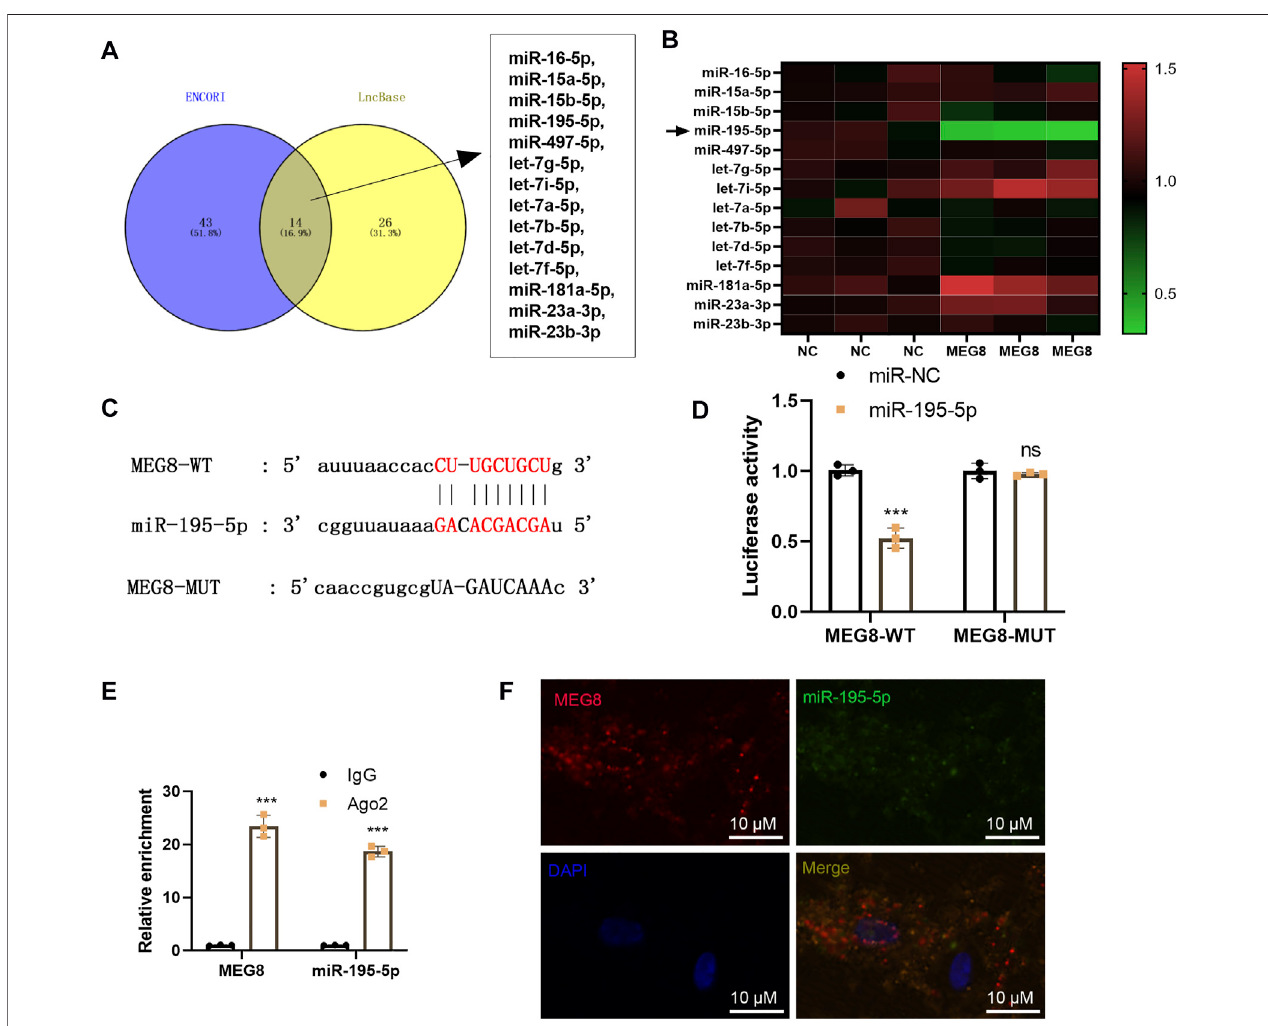
FIGURE4| MEG8targetedmiR-195-5p. (A) Twoonlinedatabases,includingENCORI(TheEncyclopediaofRNAInteractomes)(http://starbase.sysu.edu.cn/)and LncBase Experimental v.2 (http://carolina.imis.athena-innovation.gr/diana_tools/web/index.php?r (cid:2) lncbasev2%2Findex) were used for exploring the potential miRNAs asMEG8 ’ targets. (B) qRT-PCRwasusedfordetectinghsa-miR-16-5p,hsa-miR-15a-5p,hsa-miR-15b-5p,hsa-miR-195-5p,hsa-miR-497-5p,hsa-let-7g-5p,hsa-let- 7i-5p, hsa-let-7a-5p, hsa-let-7b-5p, hsa-let-7d-5p, hsa-let-7f-5p, hsa-miR-181a-5p, hsa-miR-23a-3p, hsa-miR-23b-3p in MEG8-overexpressed A-10 cells. (C) ThebindingsitesbetweenMEG8andmiR-195-5p; (D) Thedual-luciferasereporterassaywasimplementedtocon fi rmthebindingrelationshipbetweenMEG8andmiR- 195-5p. (E) RIPveri fi edthebindingofMEG8withmiR-195-5p.TheenrichmentofMEG8andmiR-195-5pwasdetectedbyqRT-PCR; (F) FISHobservedtheintracellular bindingofmiR-195-5p(green)andMEG8(red).NS p > 0.05,*** p < 0.001(vs.miR-NCgroup)Allexperimentswererepeatedthreetimes,andeachtimewasperformedin